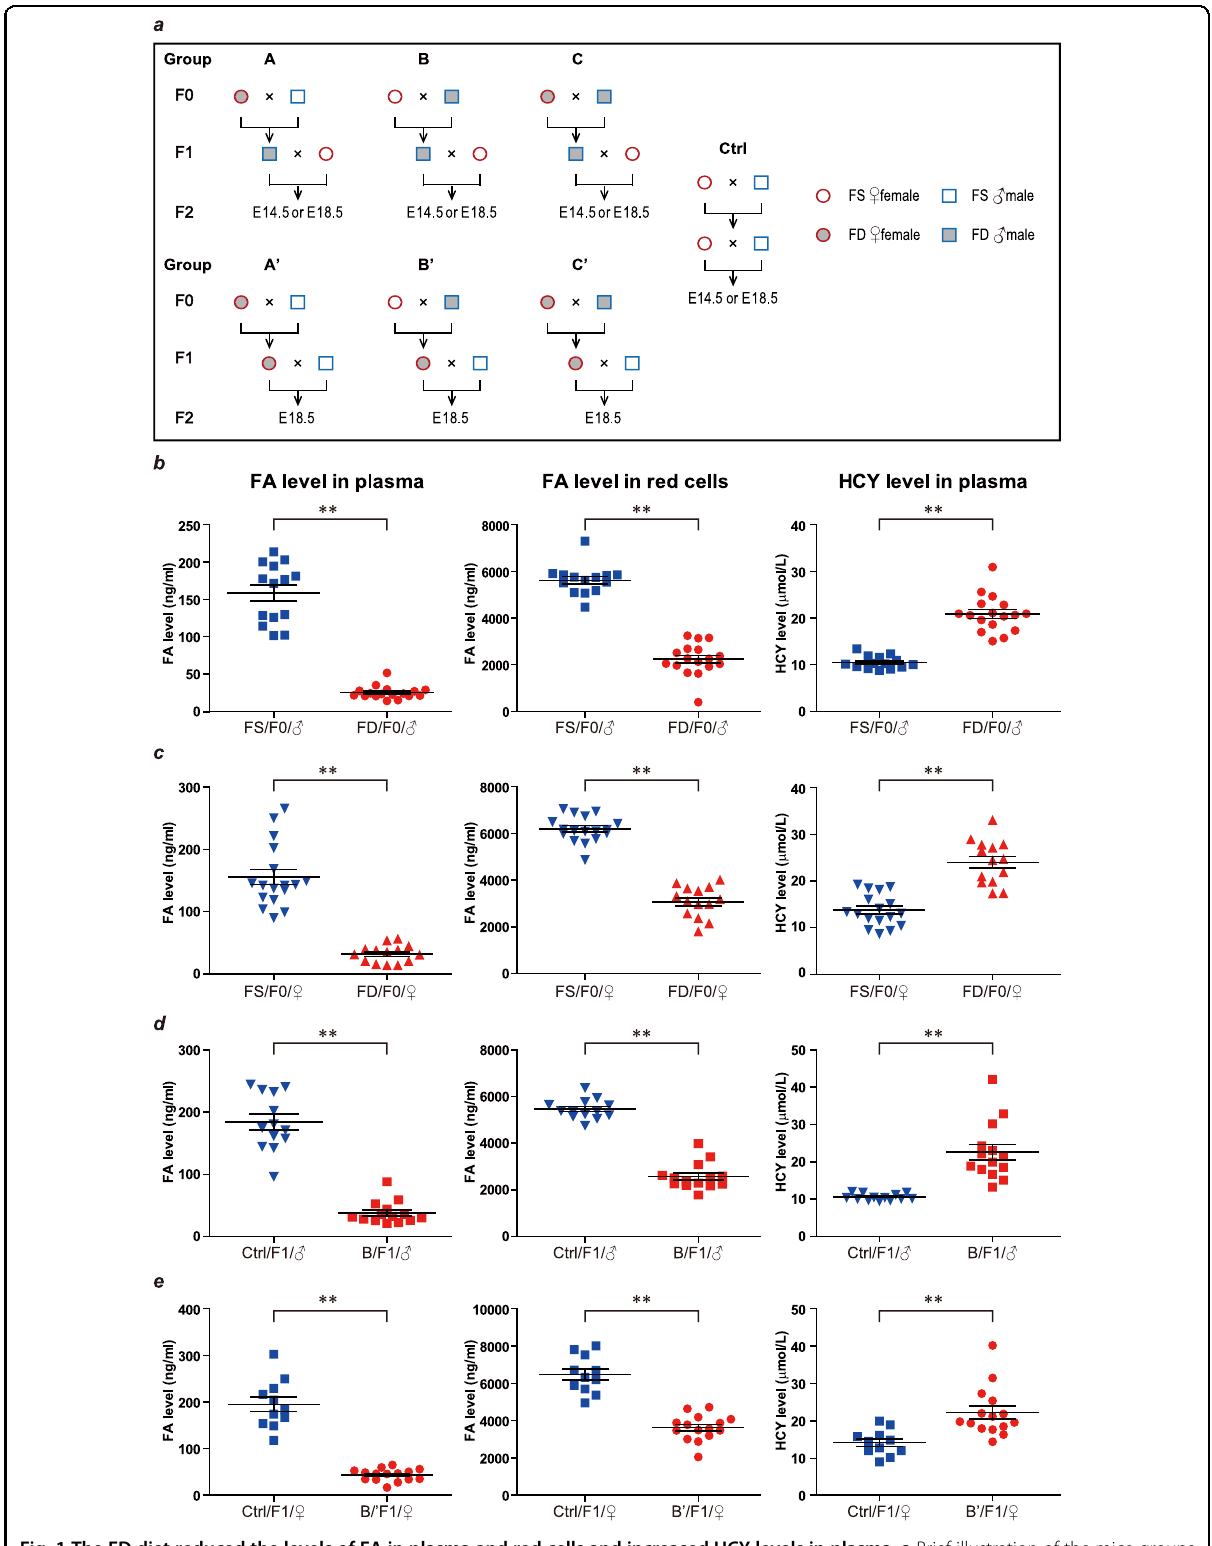
Fig. 1 The FD diet reduced the levels of FA in plasma and red cells and increased HCY levels in plasma. a Brief illustration of the mice groups used in this study. Group A, B, C used F1 males fed the FD diet to cross with females fed the normal diet to produce F2; while group A ’ , B ’ , C ’ used F1 females fed the FD diet to cross with males fed the normal diet to produce F2. b – e The FA levels in plasma and red cells, and HCY levels in plasma in F0 males ( b ), F0 females ( c ), F1 males in group B ( d ), and F1 females in group B ’ ( e ) were examined at 20 – 25